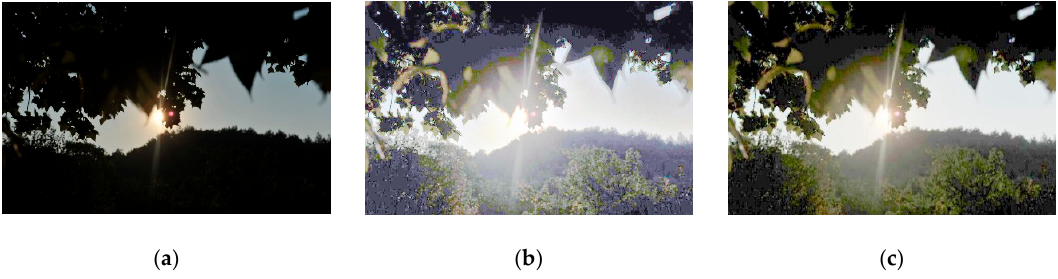
Figure 4. Comparison of the Retinex algorithm and the histogram equalization algorithm in image enhancement. Figure ( a ) is the original image. Figure ( b ) is enhanced by the histogram equalization algorithm. Figure ( c ) is enhanced by the Retinex algorithm.